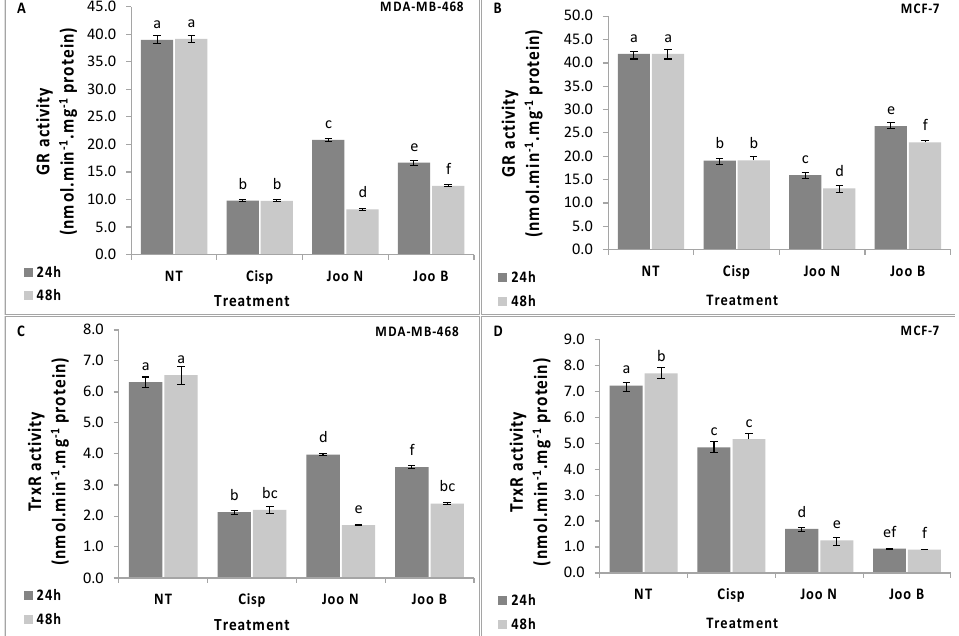
Figure 4. Activities of glutathione reductase (GR, A and B ) and thioredoxin reductase (TrxR, C and D ) in the MDA-MB-468 ( A and C) and MCF-7 ( B and D) cell lines after treatment with methanolic extracts of Joo needles ( Joo N) and Joo berries ( Joo B). Each value represents the mean of six replicates. Bars represent the standard error. Different letters indicate significant differences among treatments at p = 0.05.